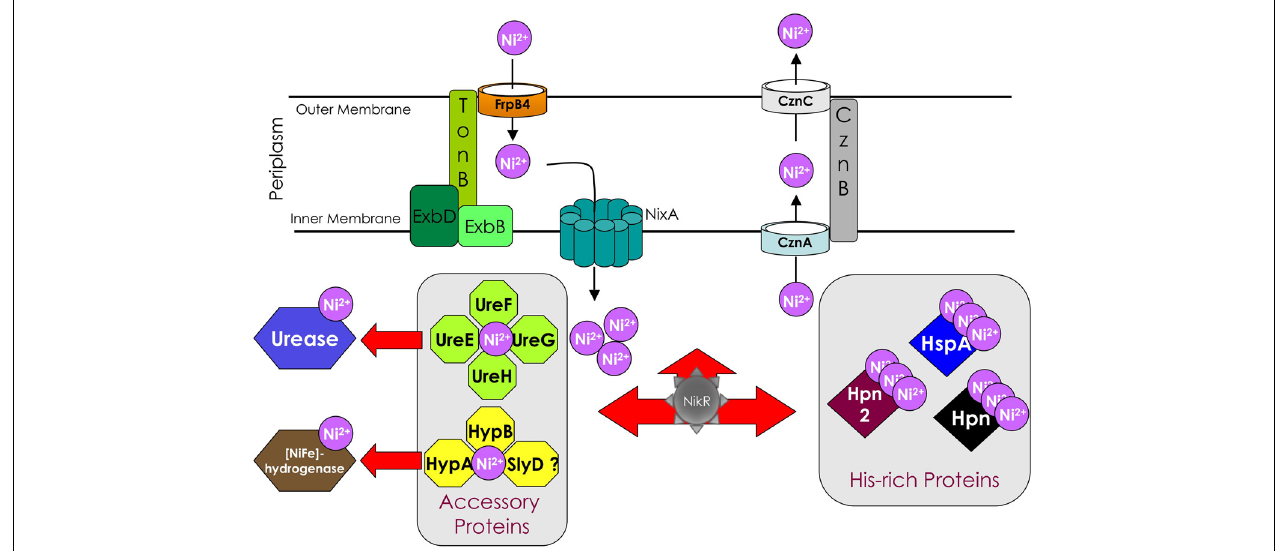
FIGURE 1 | Schematic representation of the Helicobacter pylori major components involved in nickel uptake, efflux, trafficking and incorporation into the two nickel metalloenzymes urease and [NiFe] hydrogenase and of the nickel-responsive transcriptional regulator